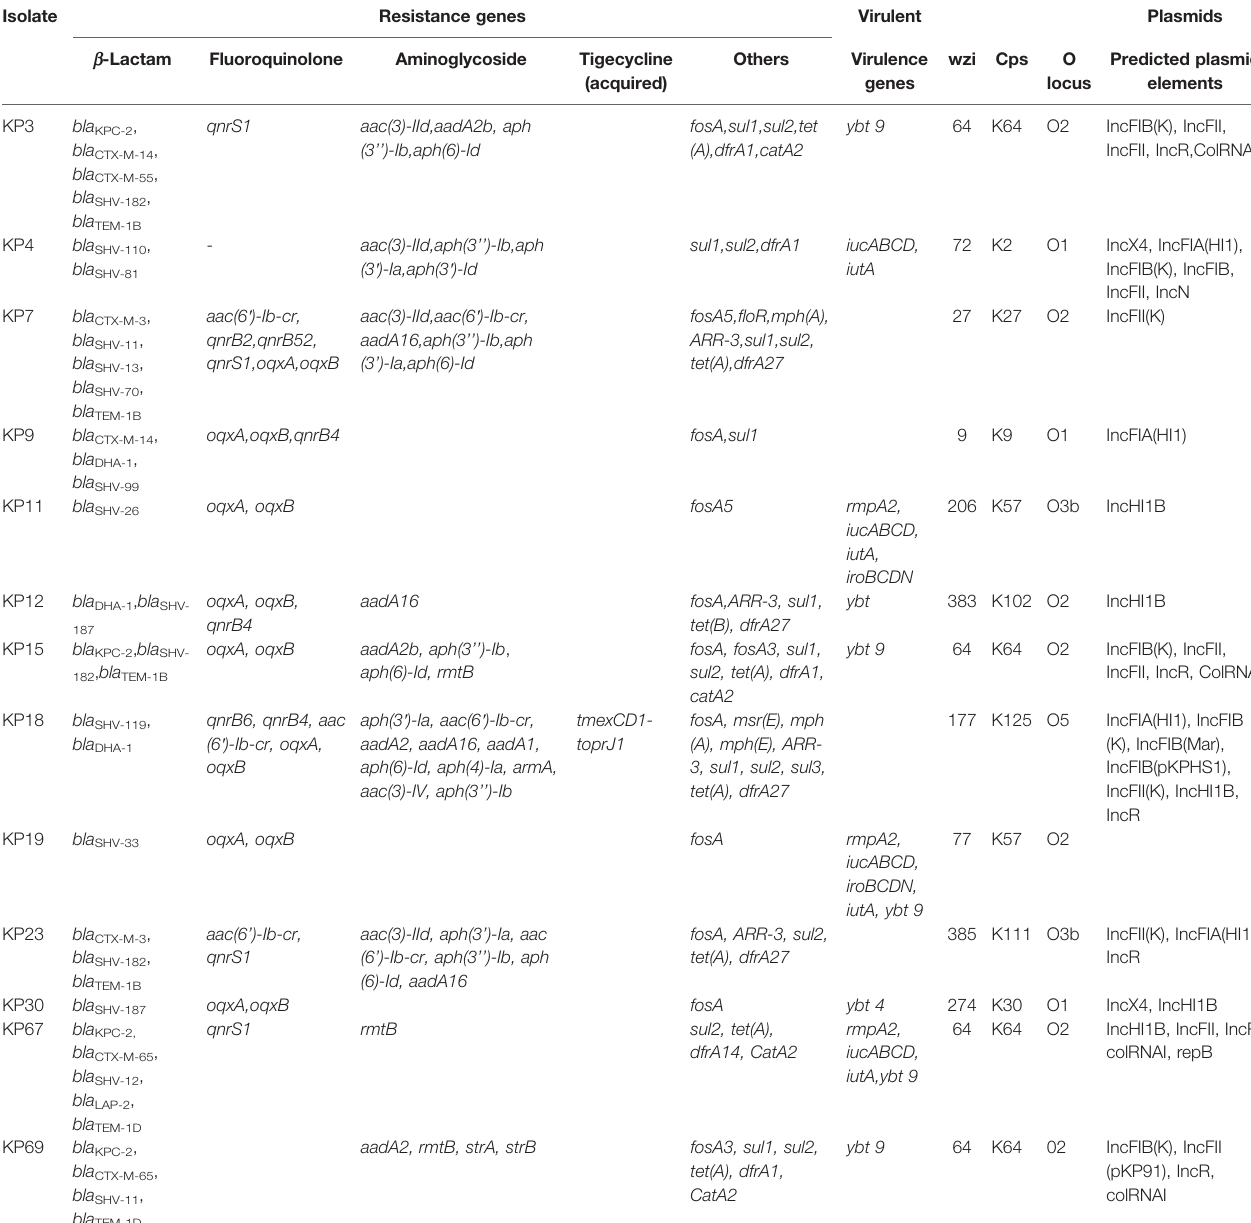
TABLE 2 | Antimicrobial-resistance genes, virulence genes, and serotypes of colistin-resistant Klebsiella pneumoniae isolates.